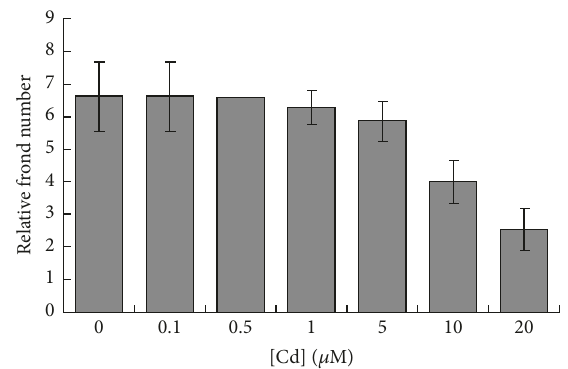
Figure 2: Growth of duckweed during cultivation in medium containing various concentrations of Cd ( 𝜇